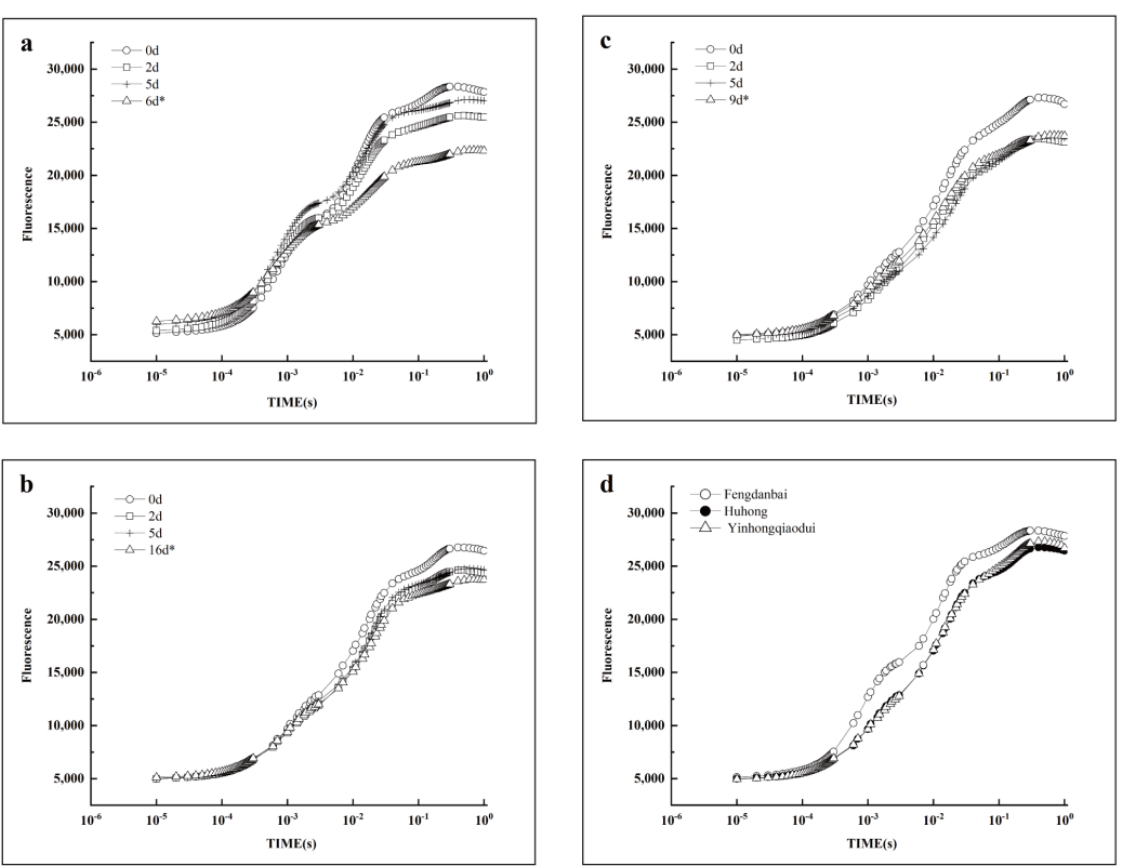
Figure 3. Effects of high-temperature stress on the rapid chlorophyll fluorescence induction curves of ‘Fengdanbai’ ‘Yinhongqiaodui’ and ‘Huhong’cultivars of peony ( a – c ): show the rapid chlorophyll fluorescence induction curves of ‘Fengdanbai’, ‘Huhong’, and ‘Yinhongqiaodui’, respectively; ( d ): shows the OJIP curves of the three peony varieties without stress. * Indicates the day as the time of wilting of the